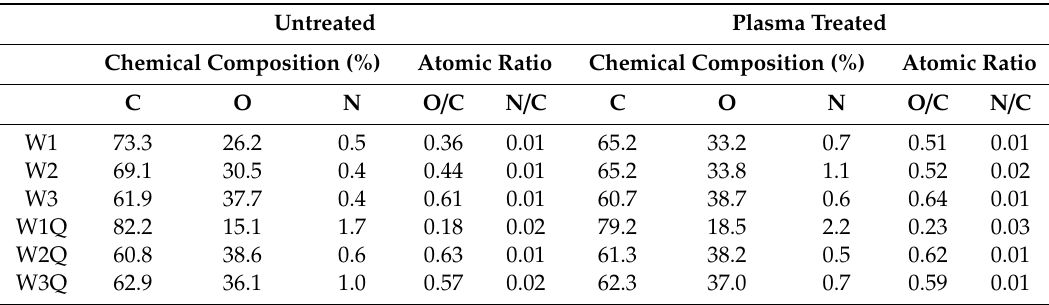
Table 2. Relative chemical composition and atomic ratio of untreated and dielectric barrier discharge (DBD) plasma-treated